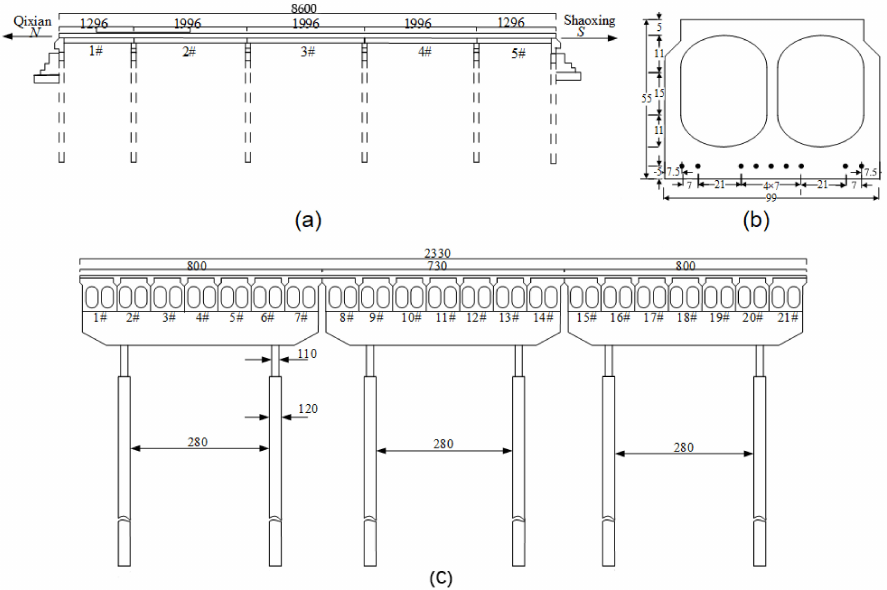
Figure 1. Background bridge (cm). ( a ) Longitudinal section. ( b ) Girder section. ( c ) Transverse